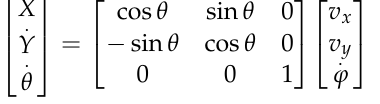
Table 1. Symbol meaning. Letter Meaning Longitudinal velocity of the center of mass